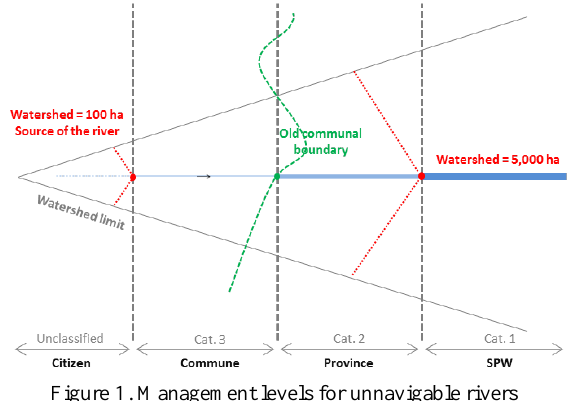
Figure 1. Management levels for unnavigable rivers